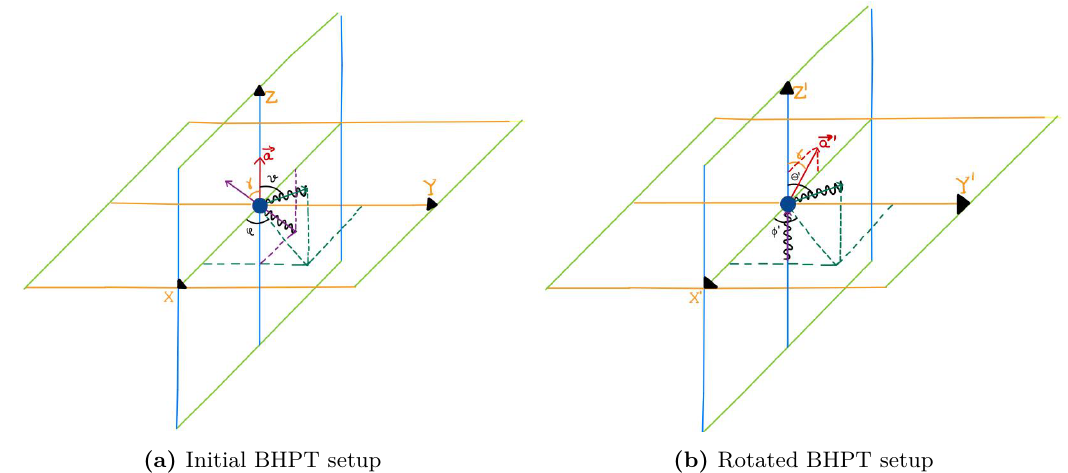
Figure 2. Wave scattering in the BHPT setup. (a) An incoming PW (purple) impinges on the BH at an angle γ with respect to the direction of the BH spin ( ~a = a ˆ z ). The outgoing scatter wave (green) moves in a general direction with angles ϑ and ϕ with respect to the Z and X axis respectively. (b) Rotated frame. In this frame, the incoming PW (purple) moves along the vertical axis, whereas the spin of the BH is rotated at an angle γ with respect to Z 0 . The outgoing scatter wave (green) now moves in the general direction θ 0 , φ 0 with respect to the Z 0 and X 0 axis